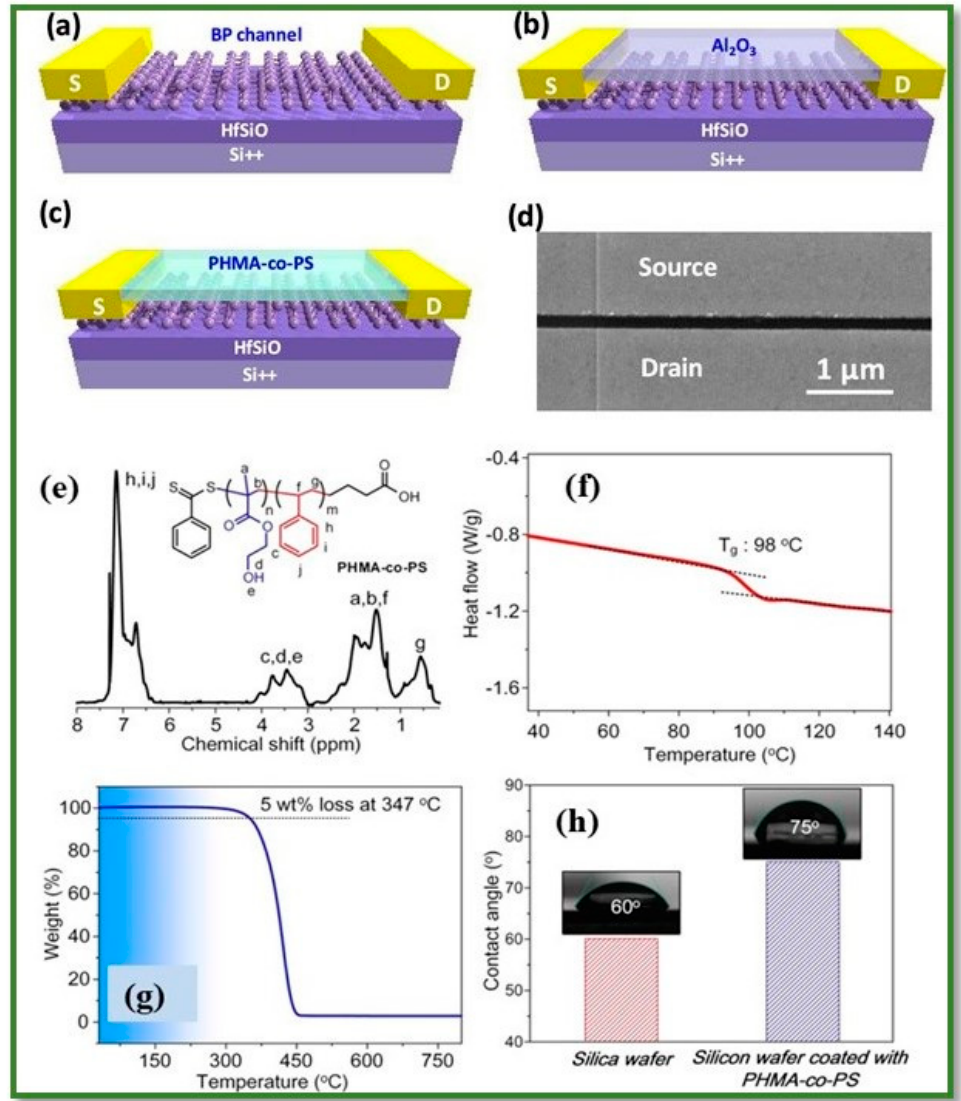
Figure 18. Schematic of the few-layer BP devices before ( a ) and after Al 2 O 3 ( b ) and PHMA – co – PS ( c ) encapsulation. S: source. D: drain. ( d ) An SEM image of a BP back-gate transistor with a 0.16 µm channel length. ( e ) NMR spectra of polymer, ( f ) DSC, and ( g ) TGA curves of PHMA–co–PS. ( h ) Contact angle for silica wafer (left side) and silicon wafer coated with PHMA–co–PS (right side). Reprinted (adapted) with permission from ACS Appl. Mater. Interfaces [134]. Copyright 2019 Amer- ican Chemical Society.